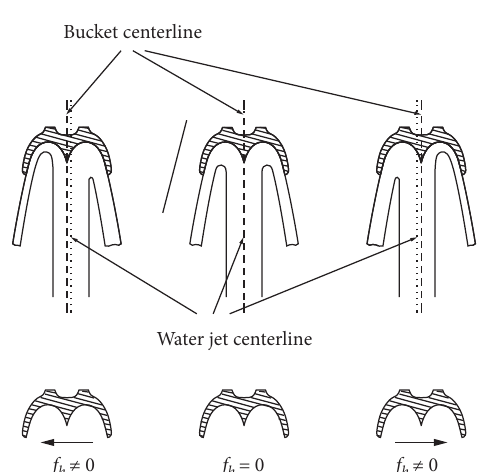
Figure 2: Force on bucket due to the difference between water jet centerline and bucket